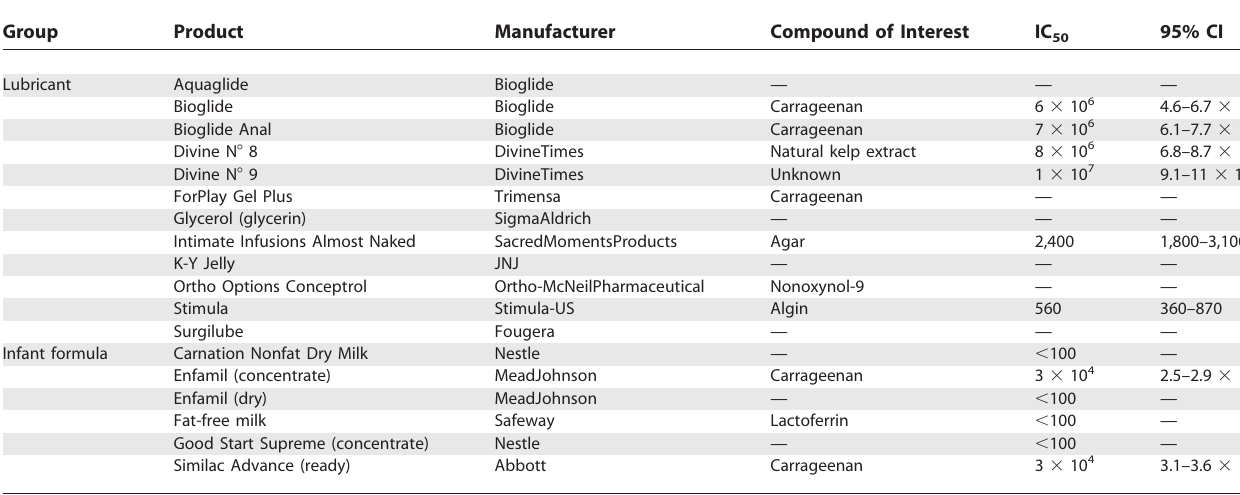
Table 3. Inhibitory Effects of Consumer Products